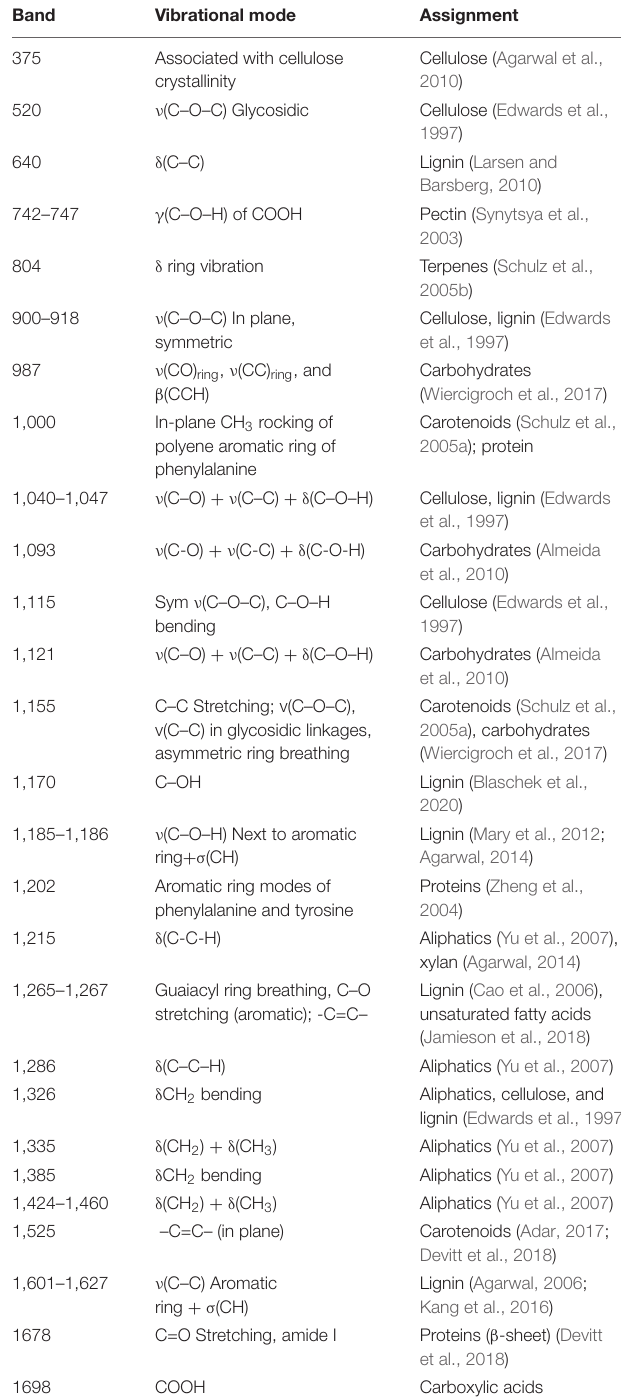
TABLE 3 | Spectral band assignments for leaves and stalks of